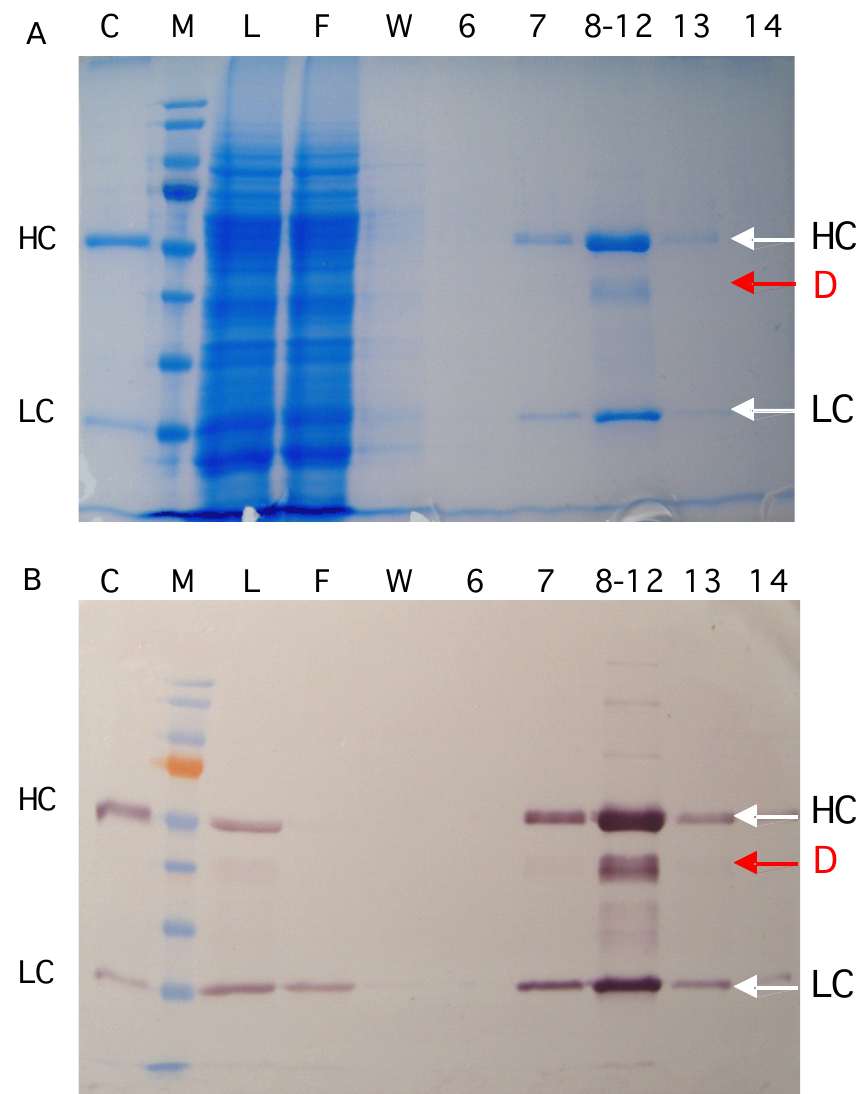
Fig. 1. Analysis of the 2G12 purification process. ( A ) Coomassie staining after SDS/PAGE (reducing conditions) of fractions taken during 2G12 purification by proteinAchromatography.( B )Westernblot(reducingconditions)ofthe2G12heavyandlightchainsfromfractionstakenduringthesamepurificationprocess. The presence of the heavy chain (HC), light chain (LC), and degradation products (D) are shown with arrows. An excess of light chain can be seen in the flow-through lane. Lanes are marked as follows: C, control; M, markers; L, load; F, flow-through; and W, wash. Numbers represent elution fractions 6, 7, 8–12 pooled, 13, and